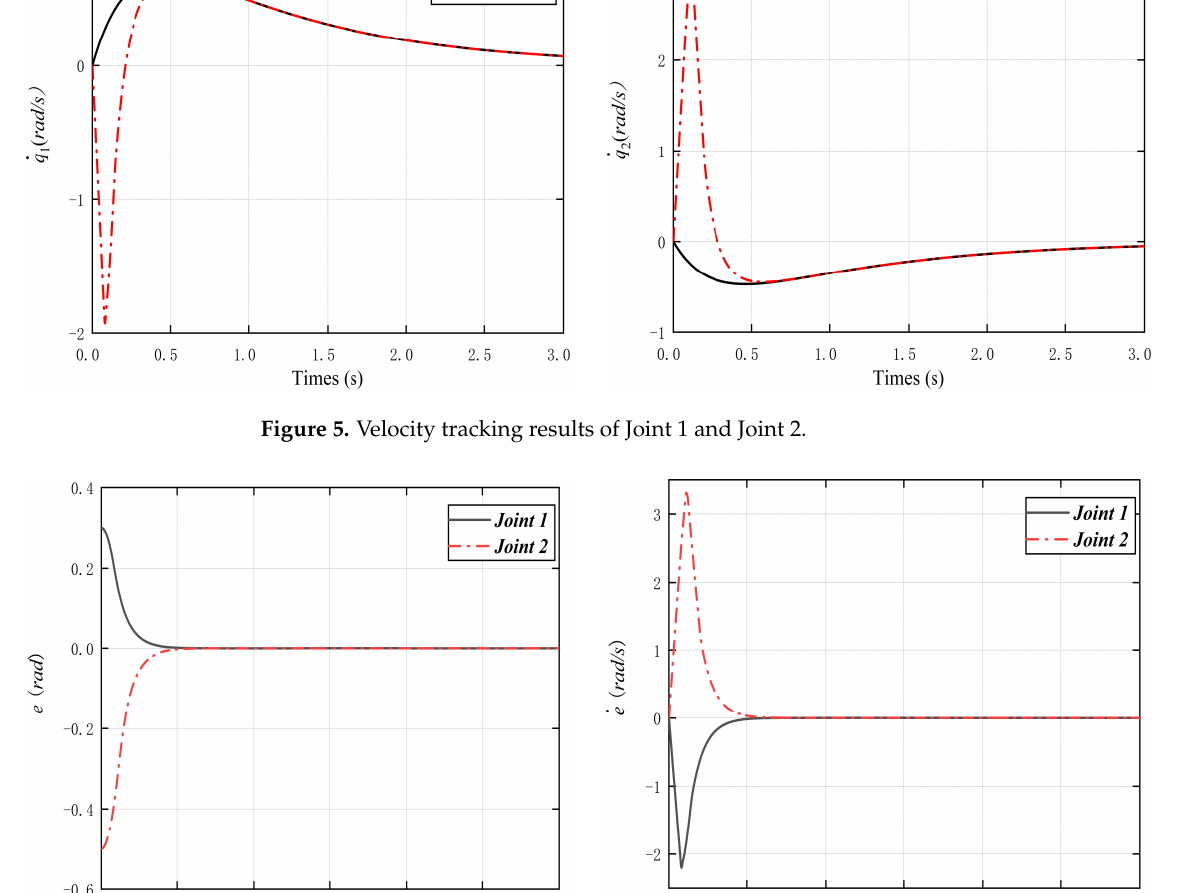
Figure 7. Position tracking error and velocity tracking error of Joint 1 and Joint 2.